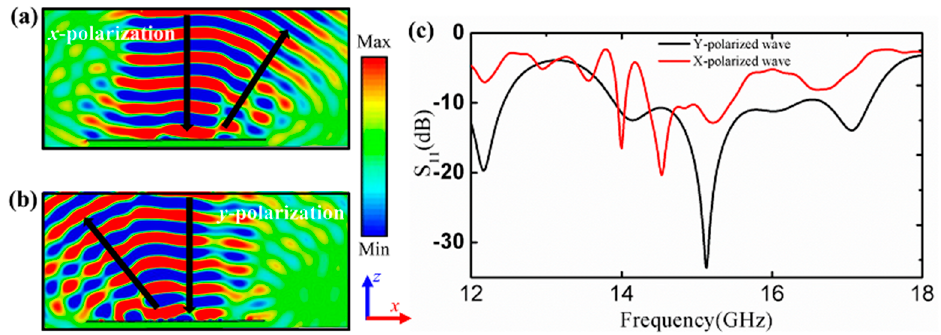
Figure 5. The near-field distribution of electric field for ( a ) x - and ( b ) y -polarized waves. ( c ) Return loss of the x - and y -polarized waves.